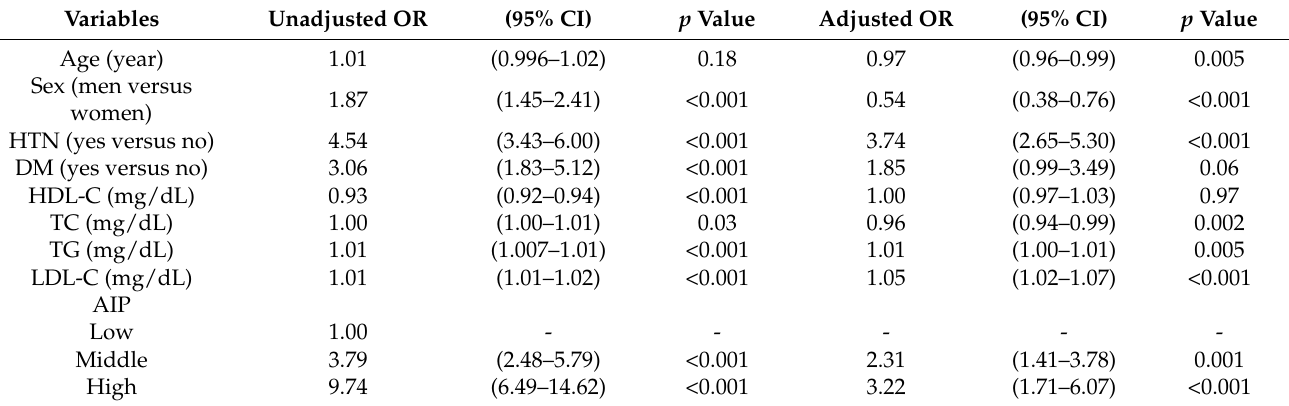
Table 3. Logistic regression analysis for obesity among study